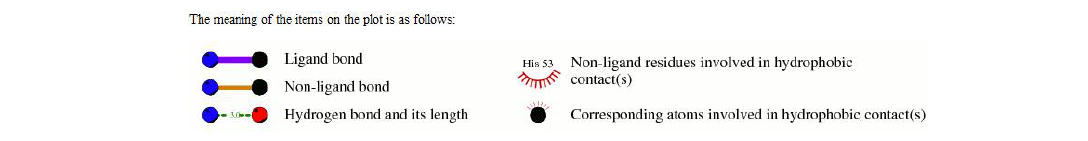
Figure 5: Protein-ligand interaction of Complex Dihydroorotate Dehydrogenase_Phytol Note: Phytol (ligand) form one hydrogen bond (represented as green broken lines with bond length) with amino acid Gln552 of dihydroorotate dehydrogenase